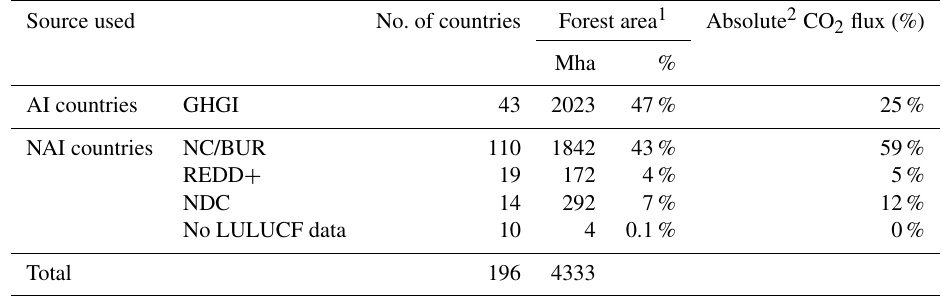
Table 3. Statistics on the sources used in this study for Annex I (AI) and non-Annex I (NAI) countries. Source used